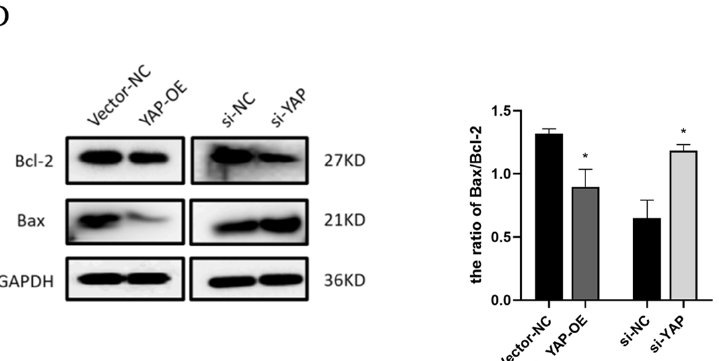
Figure 3. Downregulated YAP induces cell apoptosis and blocks cell cycle progression. ( A ) Confirmation of YAP overexpression and knockdown in HTR-8 cells after transfection with YAP-OE plasmid (YAP-OE) or YAP siRNA (si-YAP) by immunoblotting. Vector plasmid and control siRNA served as controls. ( B ) Analysis of cell cycle in HTR-8 cells transfected with YAP siRNA transfection was performed using flow cytometer. The si-NC group served as the control. The phases of G0/G1, S, and G2/M were calculated. ( C ) The percentage of apoptotic cells in si-YAP HTR-8 cells was determined by using flow cytometer. ( D ) Immunoblotting of Bax and Bcl2 protein levels in HTR-8 cells transfected with YAP-OE plasmid or YAP siRNA. The ratio of Bax and Bcl2 protein level was quantified. All results are shown as mean ± SEM. Student’s t test; * p < 0.05, *** p < 0.001.